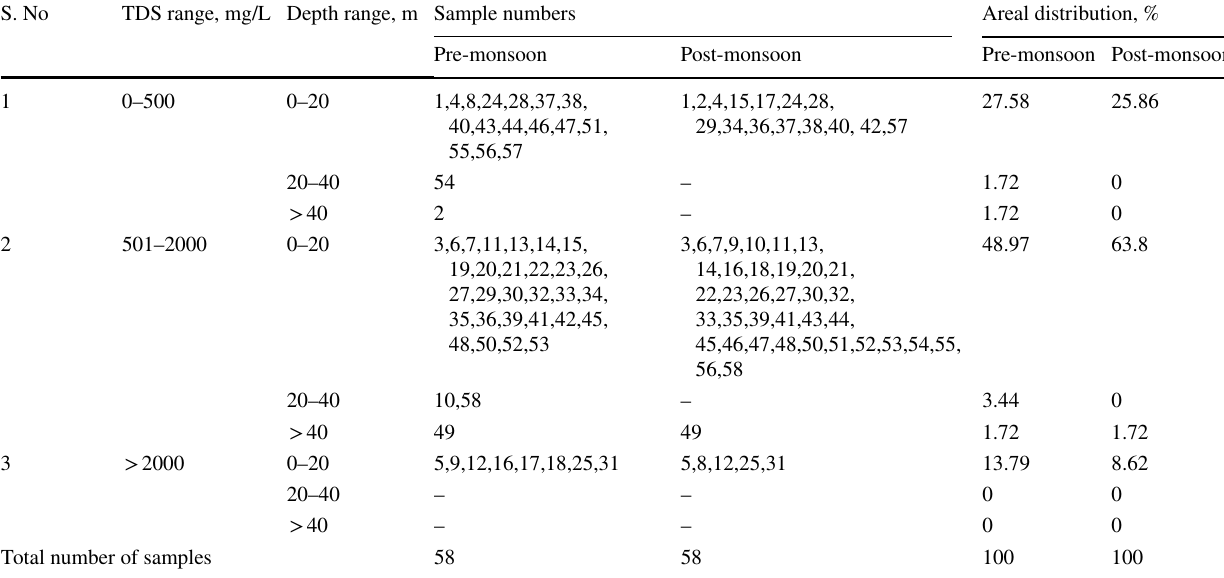
Table 4 TDS distribution in groundwater of the study area S. No TDS range, mg/L Depth range, m Sample numbers